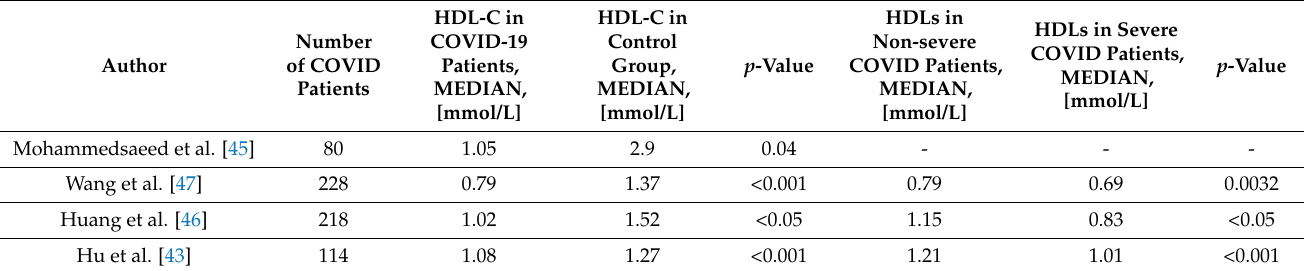
Table 2. Changes in HDL levels in patients with COVID-19 compared to healthy